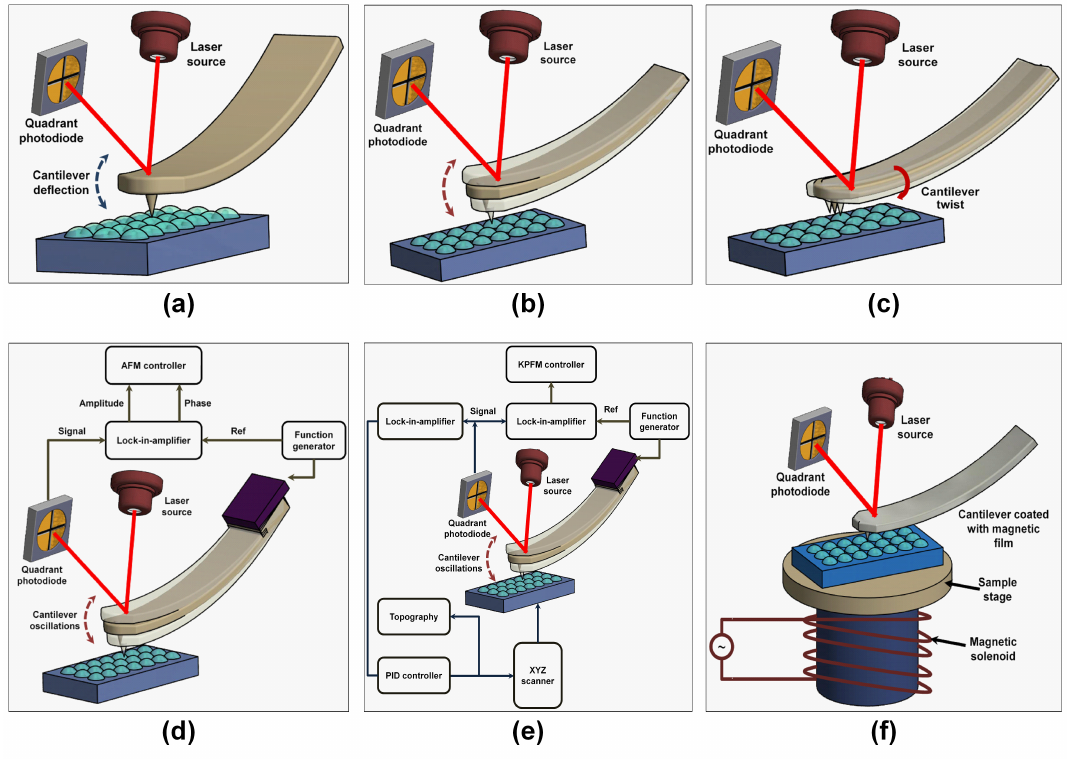
Figure 4. The AFM working modes: ( a ) contact mode, ( b ) tapping/dynamic mode, ( c ) frictional force microscopy, ( d ) phase mode, ( e ) Kelvin probe force microscopy, and ( f ) magnetic force